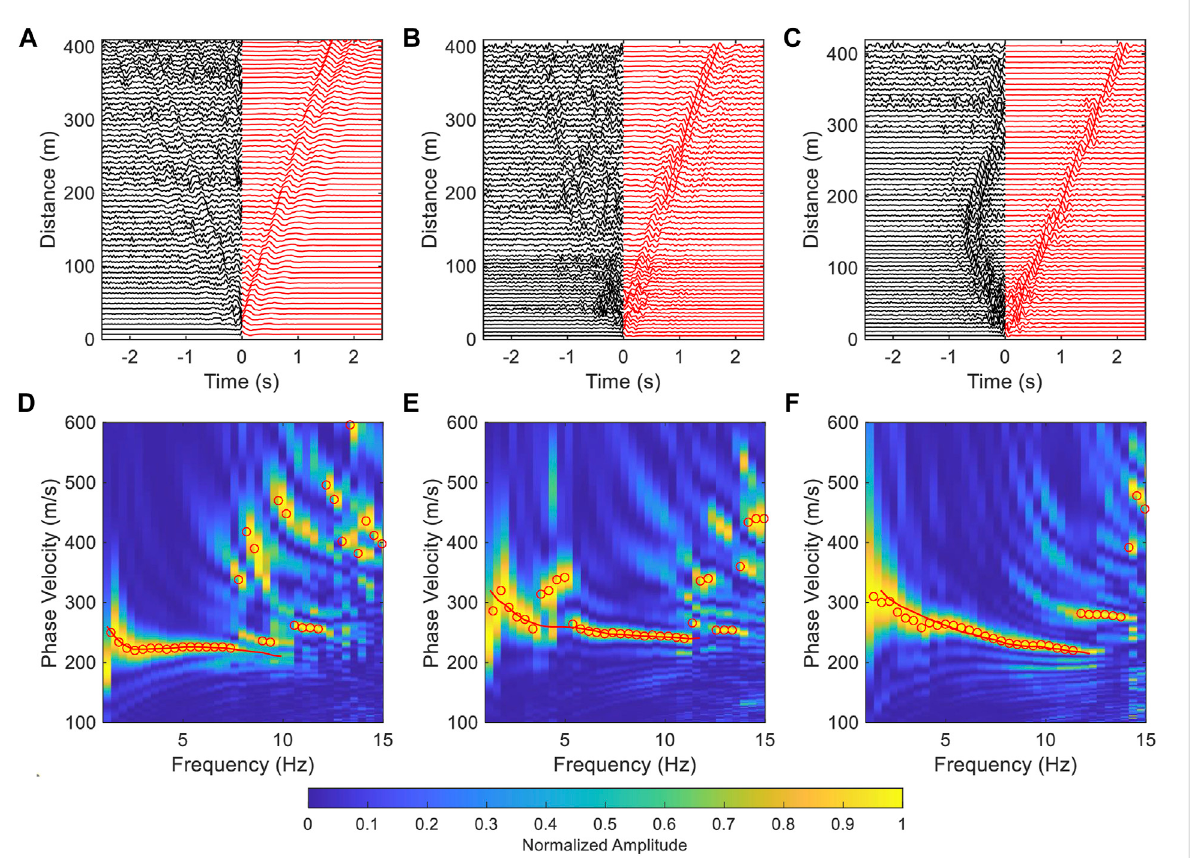
FIGURE 6 ThewaveformanddispersionspectraaftertheTSImethod. (A – C) arethewaveformsofsegment1,2,and3,respectively.Theblacklinesarethe symmetric tothepositive lag oftherawNCFs while thered linesarethedenoisedNCFs. (D – F) arethedispersion spectraofthedenoisedwaveforms of (A – C) , respectively. In (D – F) , the red circles represent the maximum energy at each frequency and the red lines are the picked dispersion